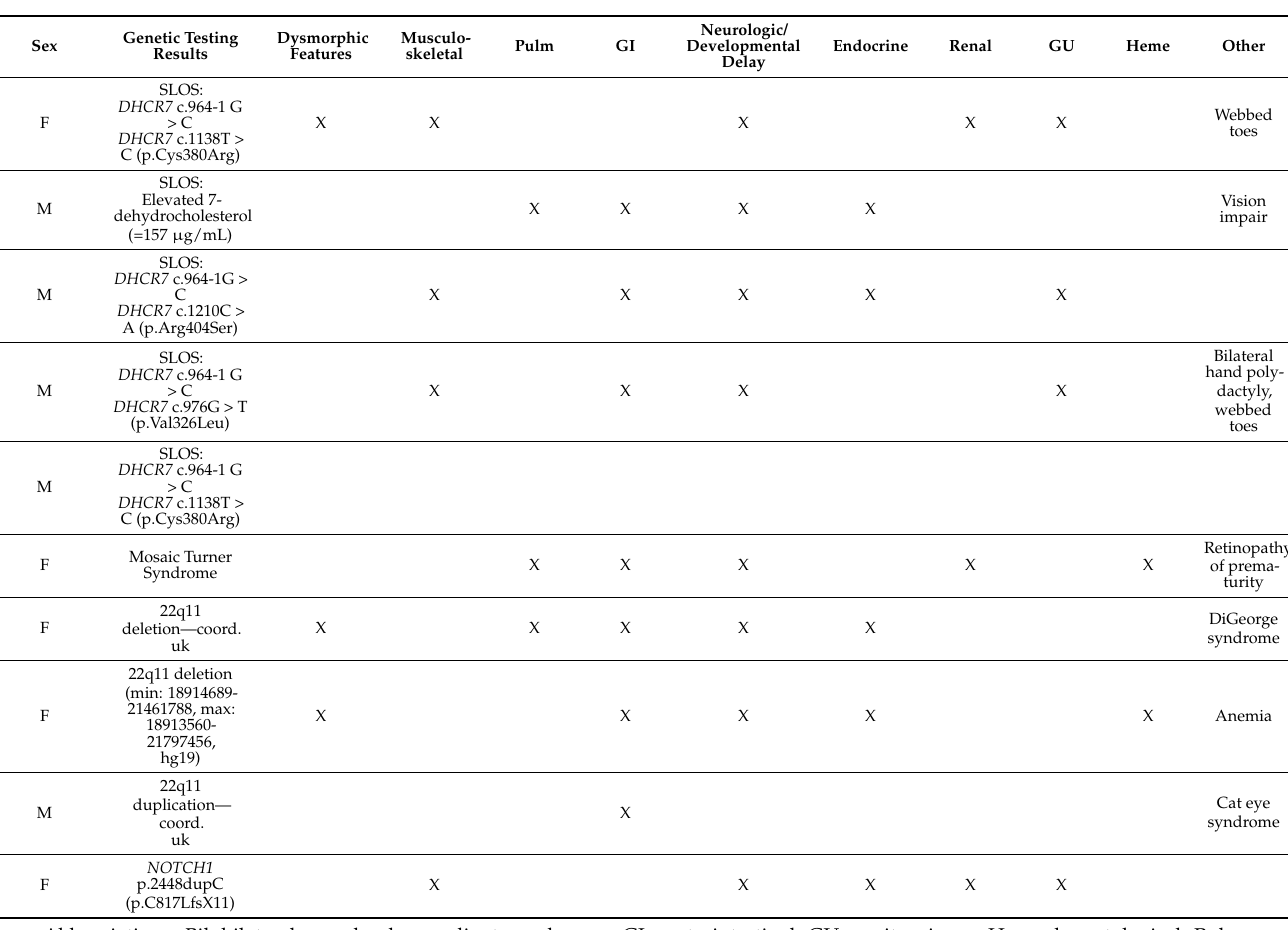
Table 3. Clinical phenotyping of PVS patients with other pathogenic variants ( n =